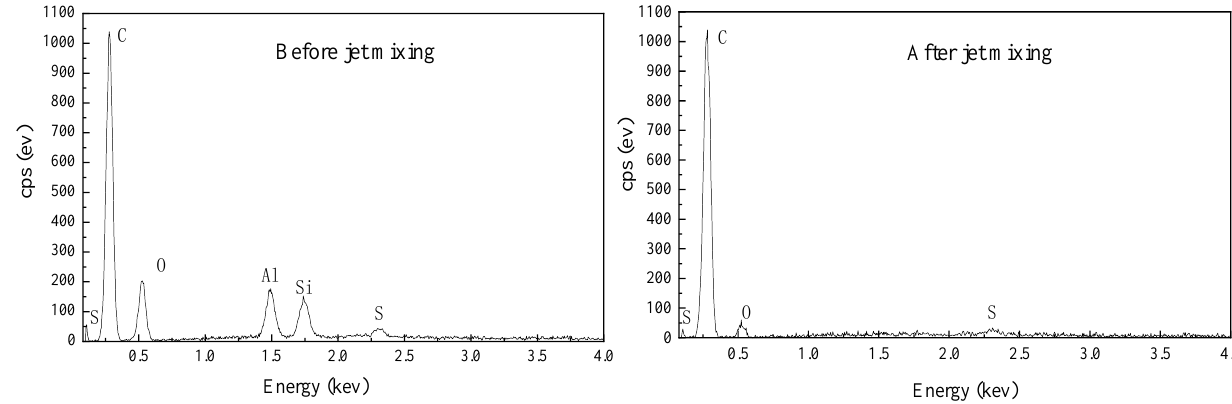
Figure 6. EDS spectrum of artificially mixed coal sample before and after jet mixing.